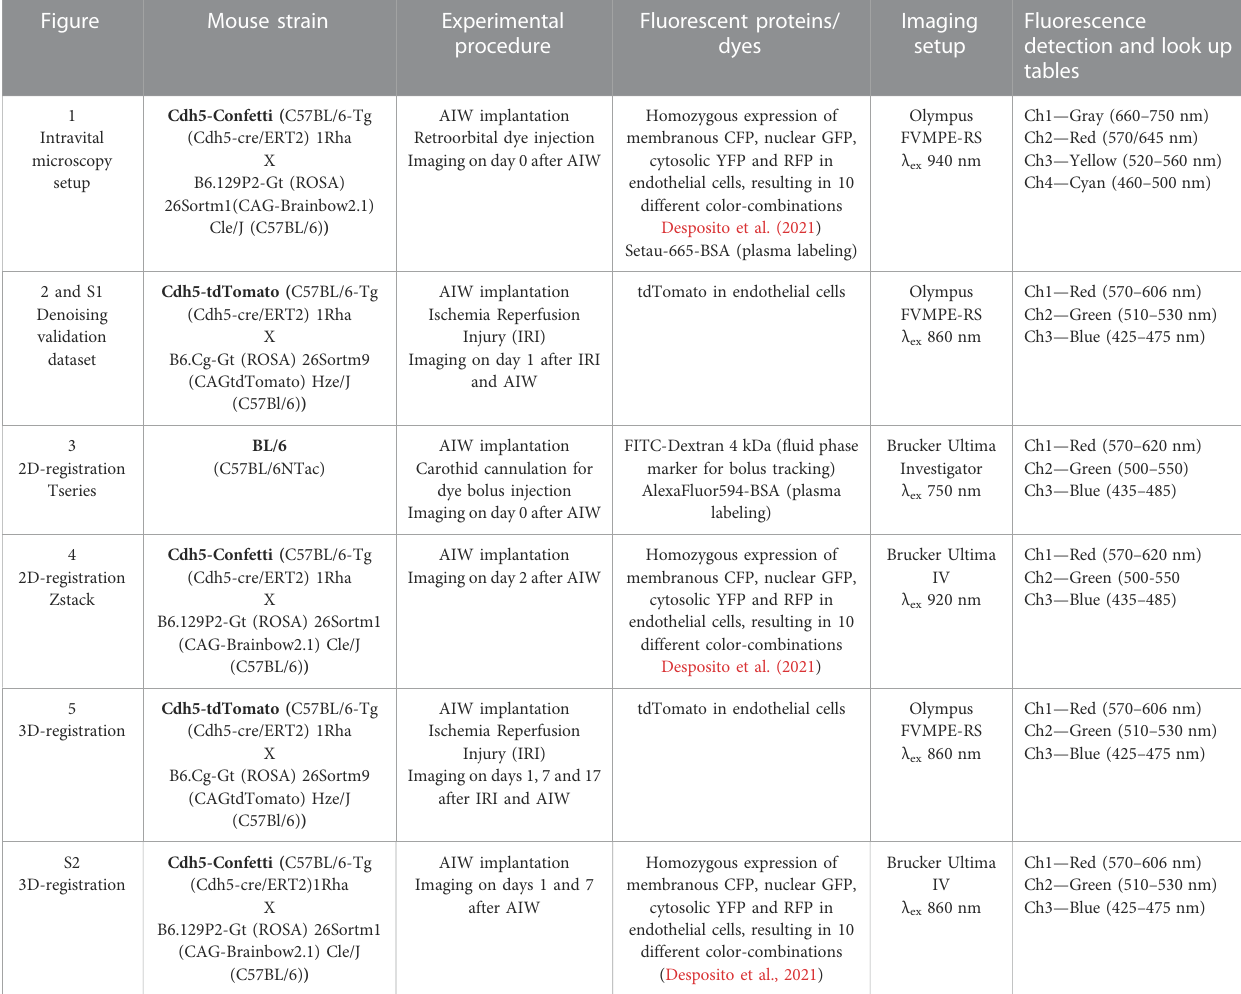
TABLE 1 Animal strains, procedures, and imaging parameters.